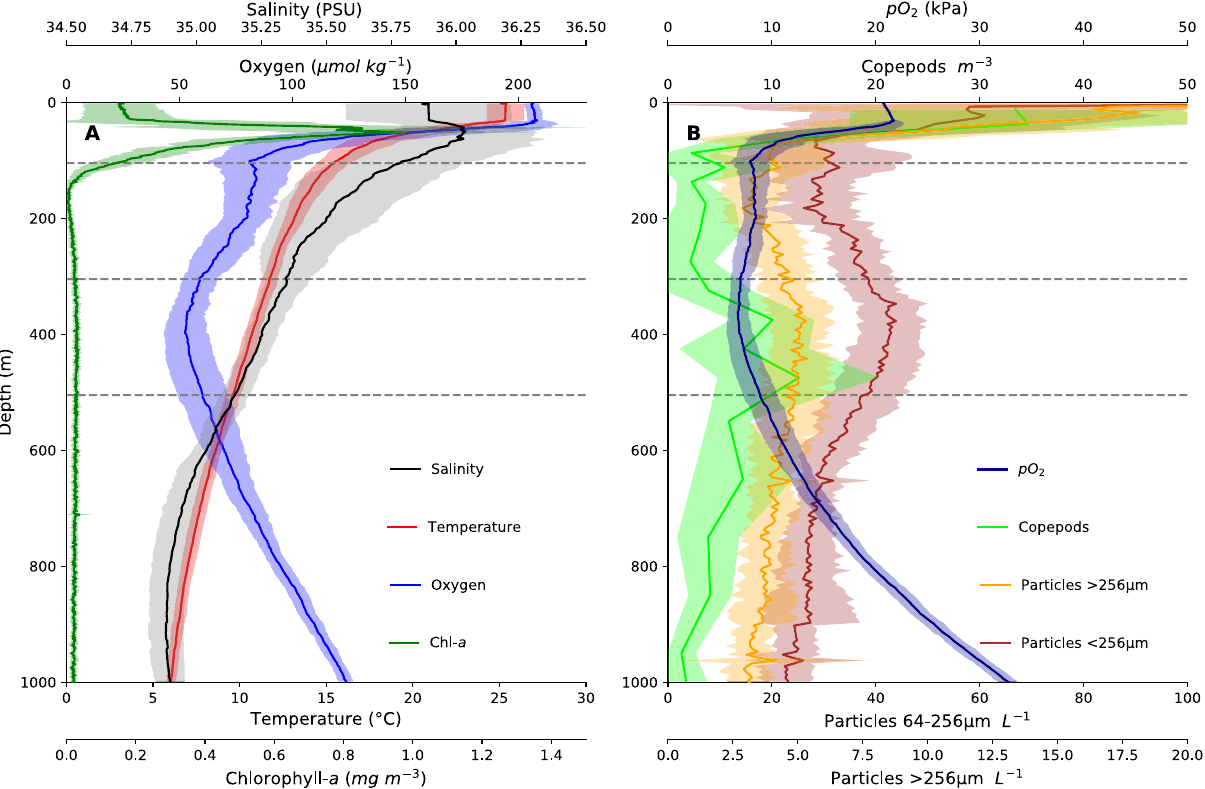
Figure 2. Hydrographic profiles of the sampled stations during MSM49 with mean (± SD) vertical distribution of chlorophyll- a (green), temperature (red) and oxygen (blue) from the CTD (left) as well as oxygen partial pressure, particle abundance (64–256 µm and > 256 µm) and copepod abundance (right). Dashed grey lines indicate four depth strata defined based upon mean hydrographic conditions (upper layer UL, upper oxycline UOC, oxygen minimum zone OMZ and lower oxycline